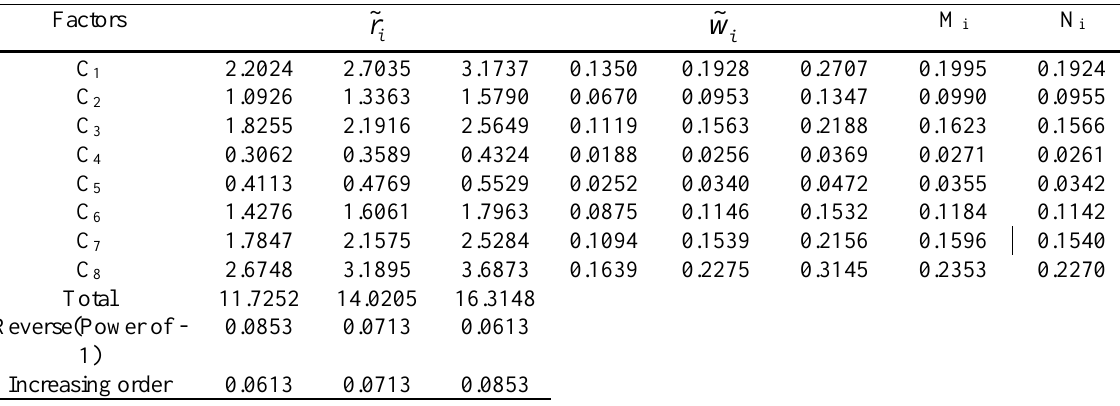
Table 14. Relative non-fuzzy and normalized weights of customer chain.